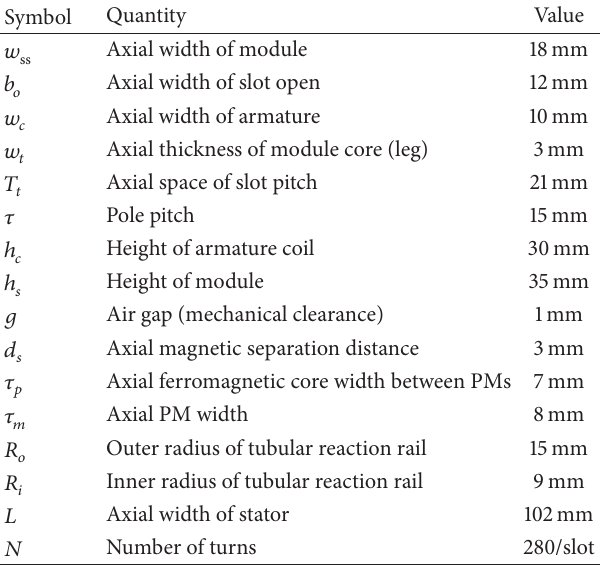
Table 1: Specifications of the